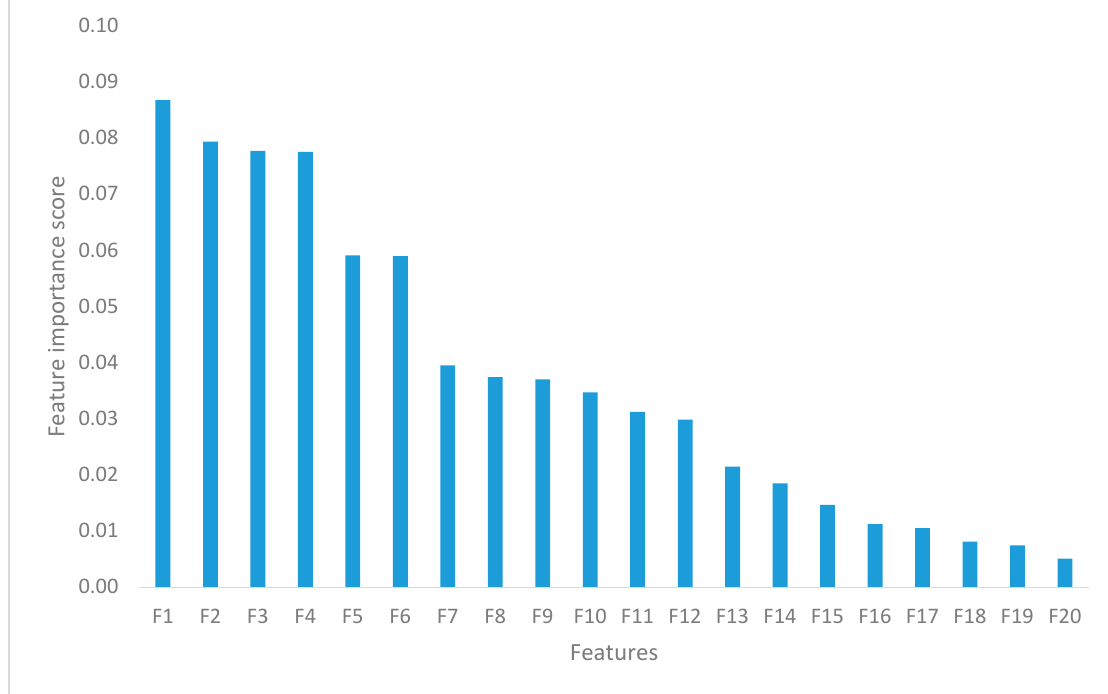
Figure 3. Top 20 RF-RFE ranked acoustic features.